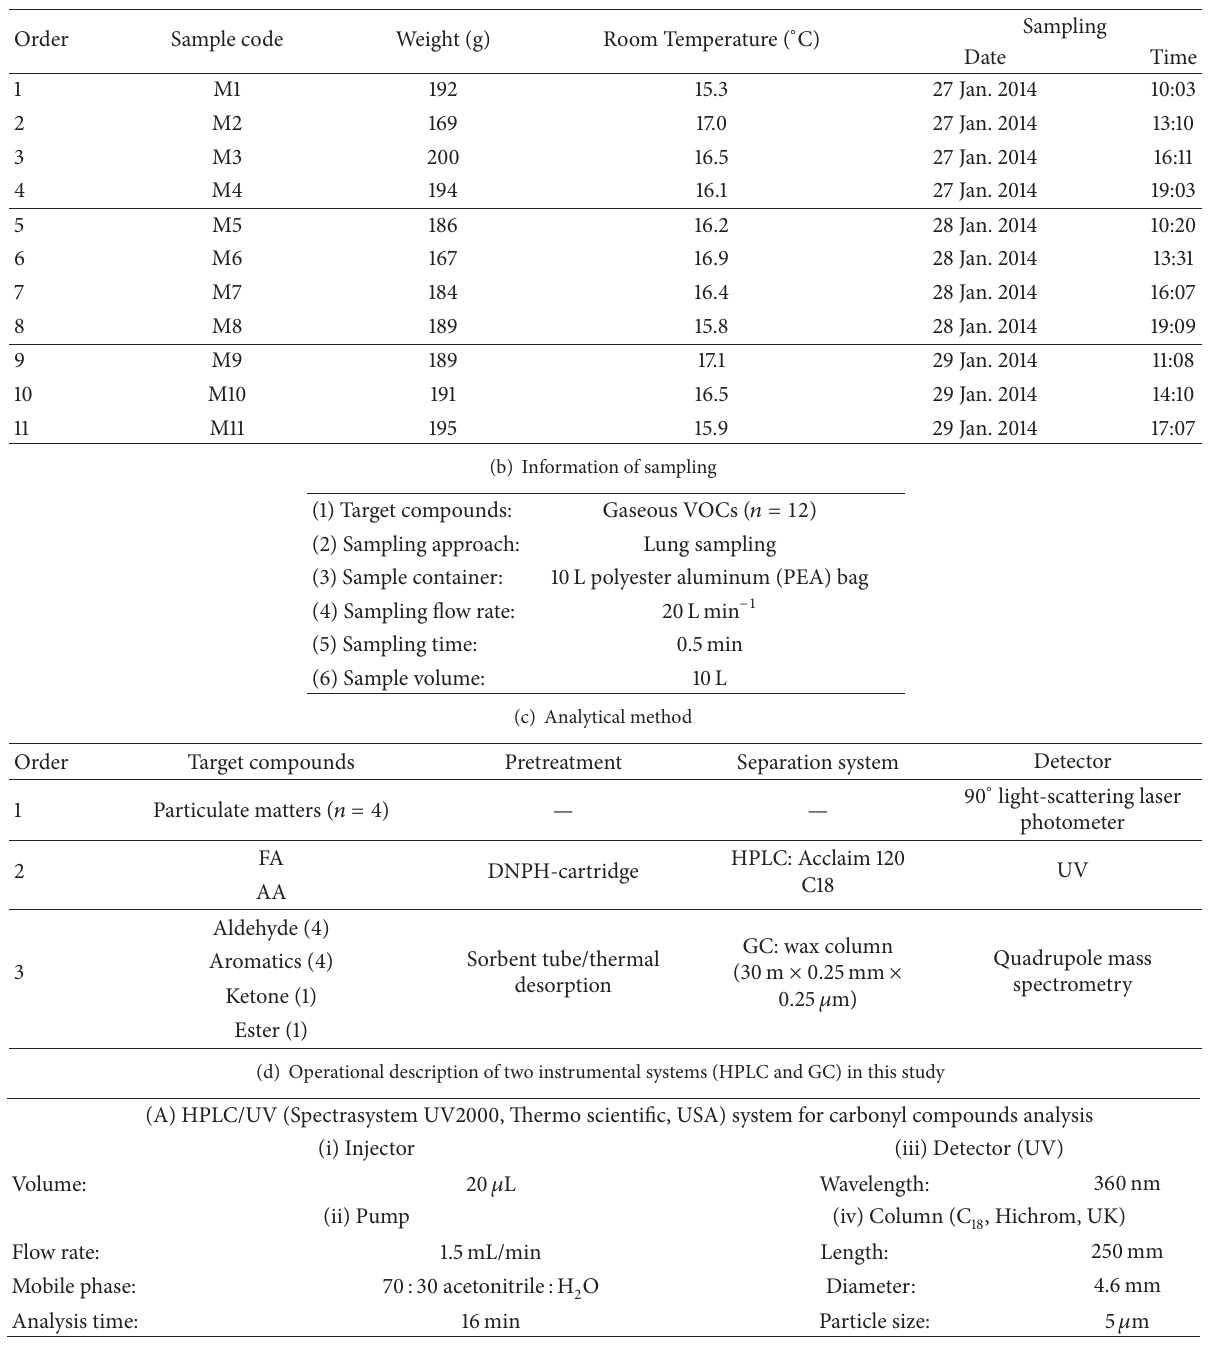
Table 2: Details of the sample, sampling, and analytical system for the analysis of smoke released from mackerel